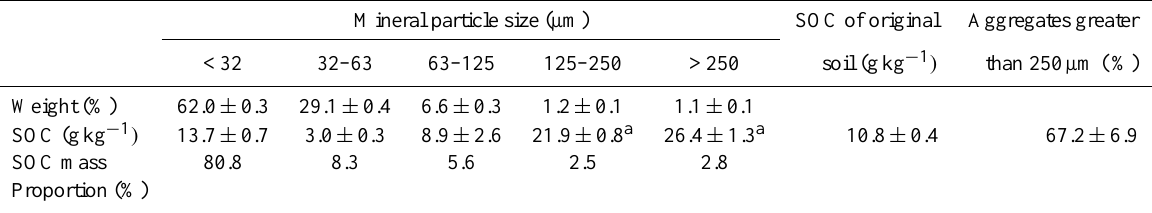
Table 1. Mineral particle size distribution, soil organic carbon (SOC) distribution across mineral particle size, average SOC of bulk soil, and the percentage of stable aggregates greater than 250µm in the silty loam used in this